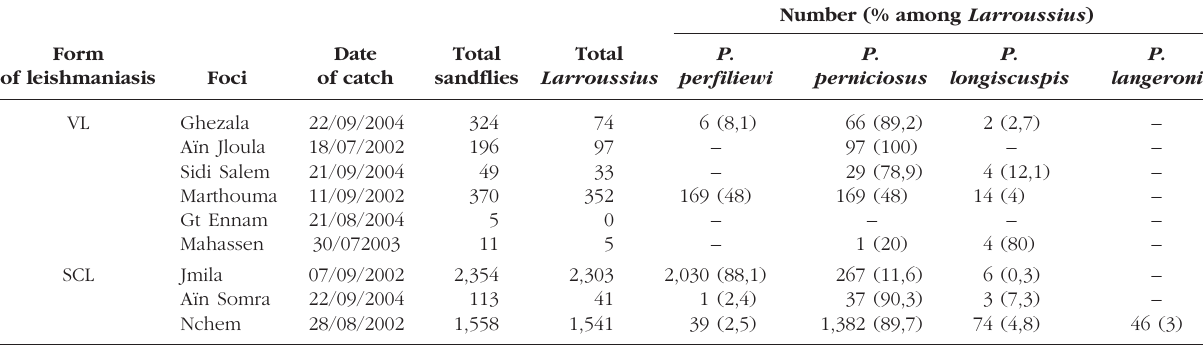
Table III. – Specific composition of subgenus Larroussius caught by CDC and sticky traps in the studied L. infantum